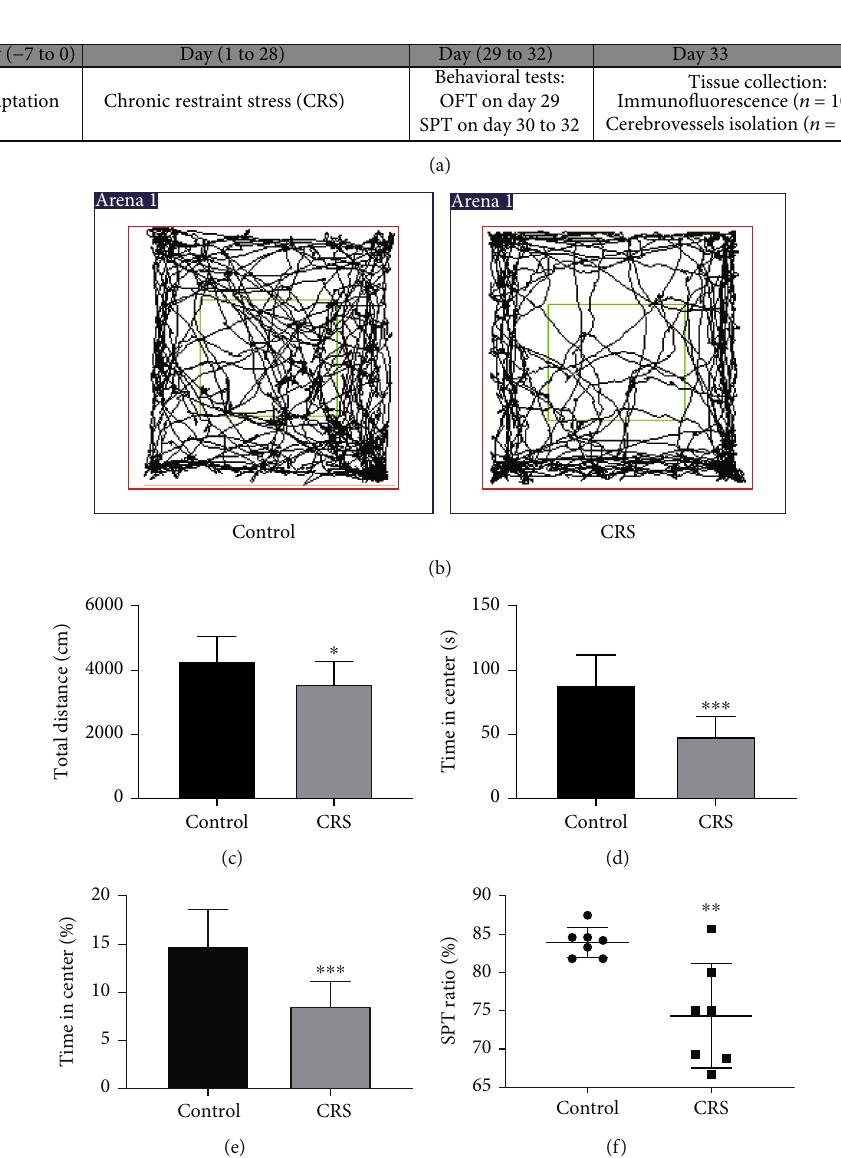
Figure 1: Chronic restraint stress (CRS) induces depressive-like behaviors. (a) Timeline for CRS, validation by behavioral tests, and tissue collection. (b) Representative images of running paths in the OFT. (c) The total running distances were decreased upon CRS. (d, e) The time in the center zone and the percentage of time in the center zone were decreased signi fi cantly. (f) CRS could induce a decrease in the SPT ratio. Values are mean ± SE . ∗ p < 0 : 05 , ∗∗ p < 0 : 01 , and ∗∗∗ p < 0 : 001 , as compared with the control